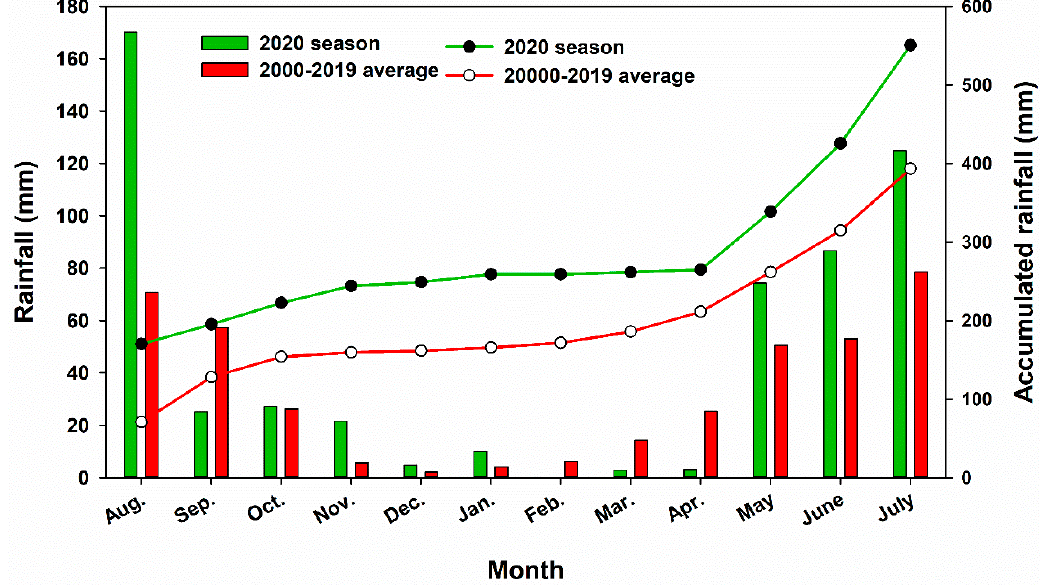
Figure 2. Monthly total precipitation in 2020 season and the long-term (2000–2019) average at the Rainfed Agricultural Experiment Station of Gansu Agricultural University.